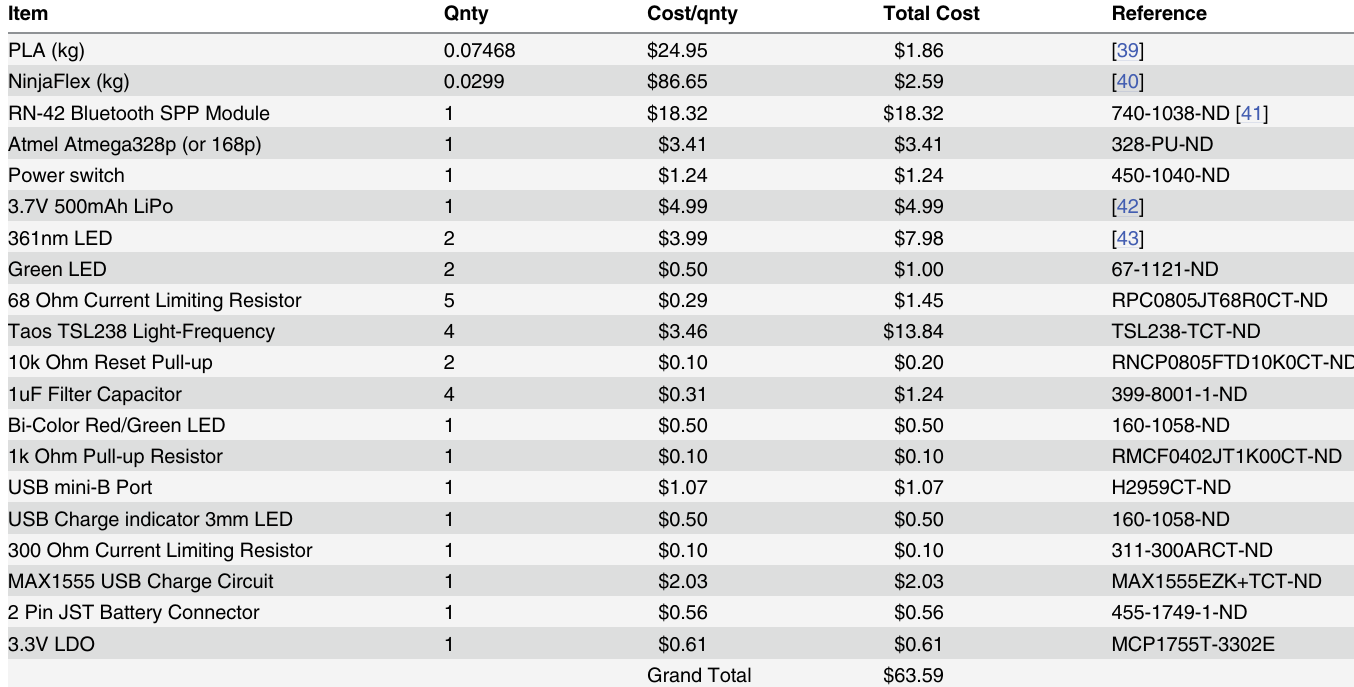
Table 1. Cost breakdown of the photometer case and electronics (Digikey part # unless externally